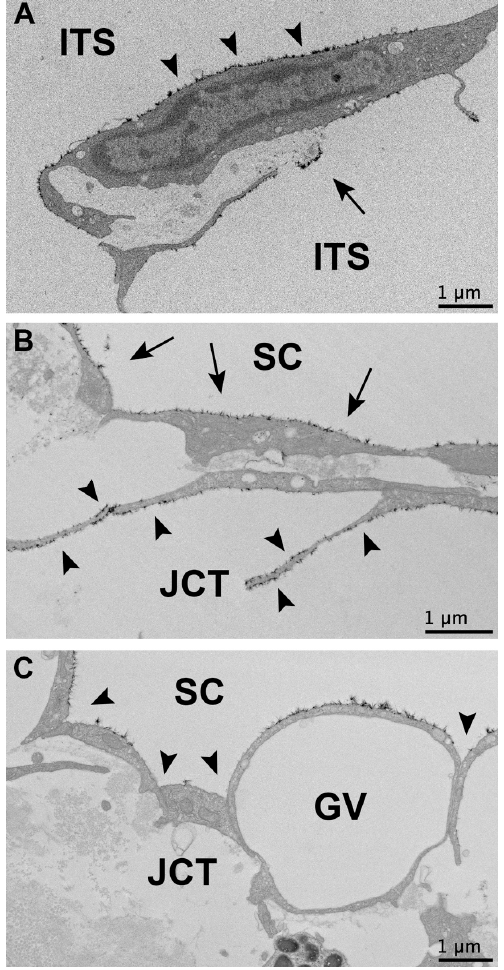
Figure 1. Non-uniform glycocalyx coverage along the trabecular outflow pathway. ( A ) A representative example of glycocalyx coverage on the trabecular beams in an undetermined-flow region of a control eye. Arrowheads indicate glycocalyx covering the trabecular cell membrane. The arrow indicates glycocalyx overlying the exposed basement membrane in a region of the trabecular beam without endothelial cell coverage. ( B ) Non-uniform glycocalyx coverage of juxtacanalicular connec- tive tissue (JCT) cells. Arrows indicate glycocalyx covering the inner wall of Schlemm’s canal (SC). Arrowheads indicate glycocalyx coverage on the JCT cells. Shown in an undetermined-flow region of a control eye. ( C ) Inner wall endothelial cell surfaces protruding into lumens displayed more glycocalyx coverage than recessed regions (arrowheads) in Schlemm’s canal (SC) and collector channels (CCs). Shown in SC in a low-flow region of a control monkey eye. No glycocalyx coverage was seen along the inner cellular membrane of the giant vacuole (GV). ITS: intertrabecular